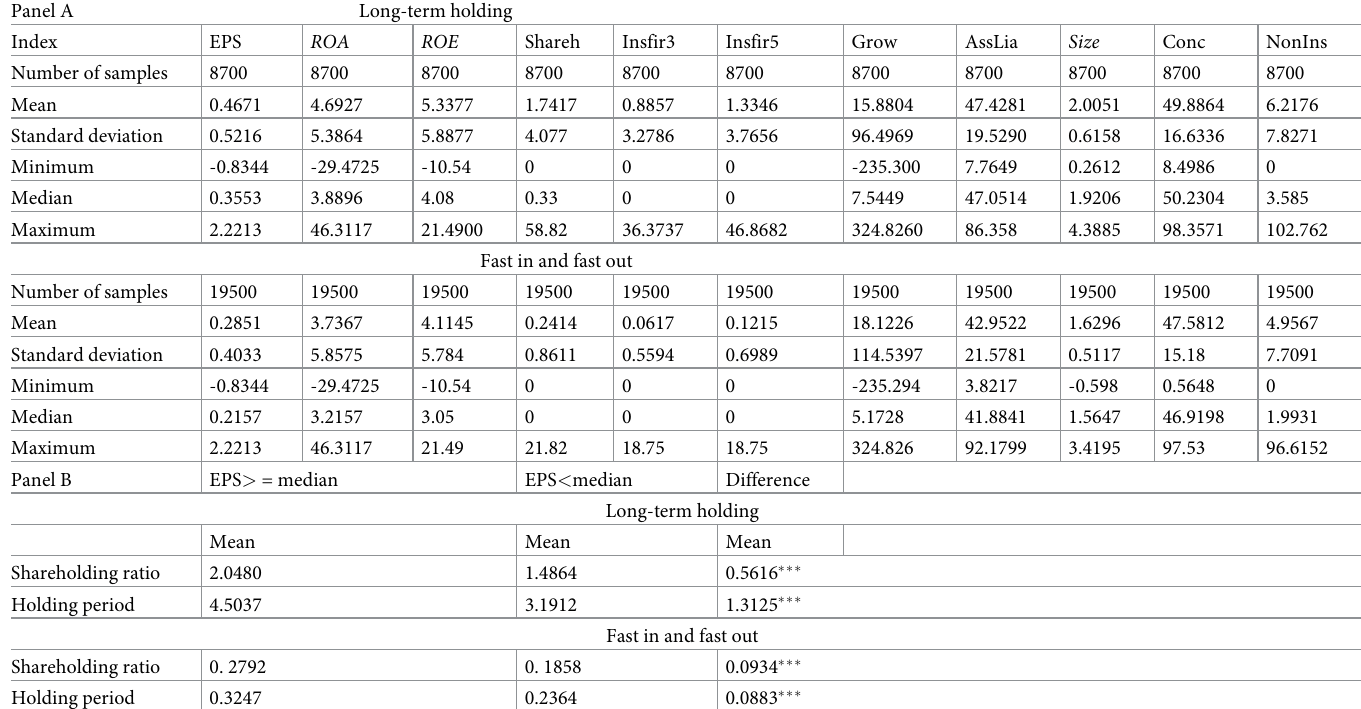
Table 2. Summary